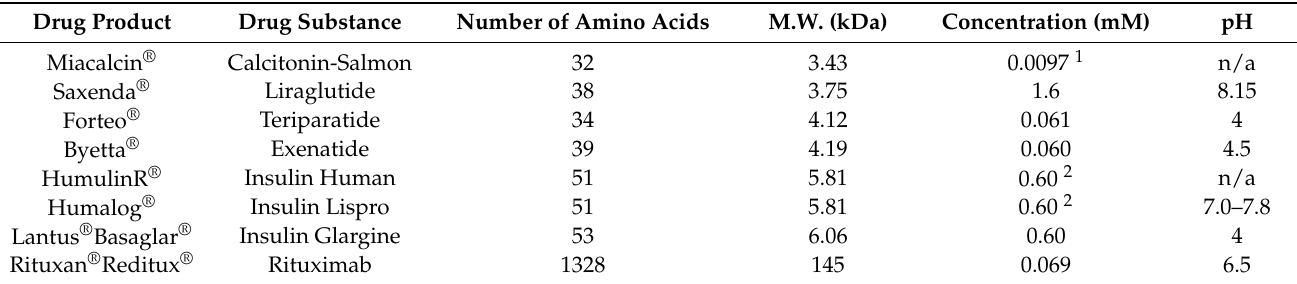
Table 1. Drug Products